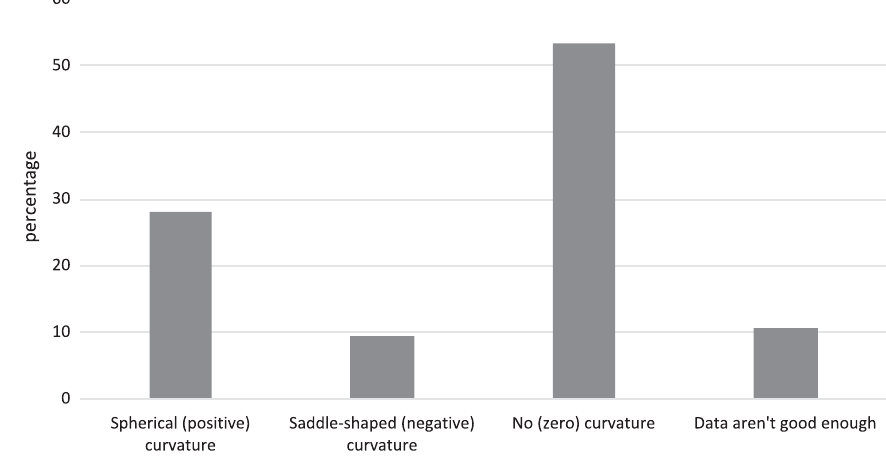
FIG. 9. ASTRO 101 Preinstruction survey responses for What does the cosmic microwave background tell us about the overall curvature of the Universe? ( N ¼ 75